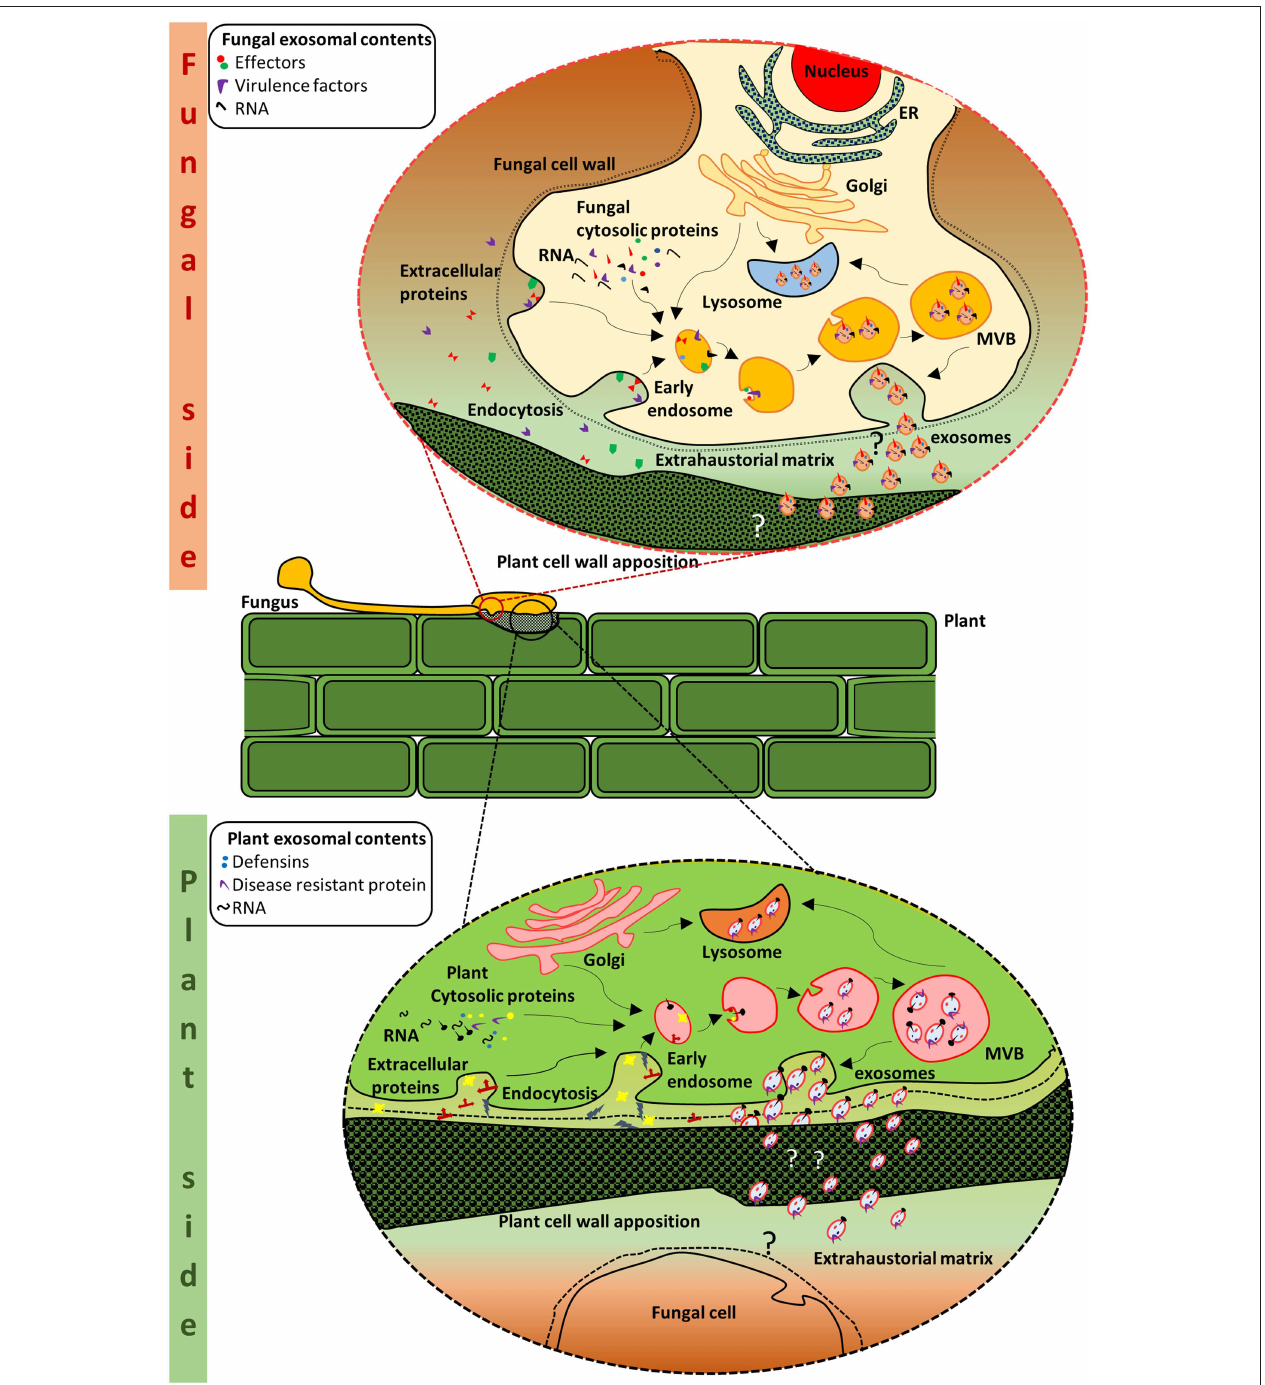
FIGURE 1 | Schematic representation of putative crosstalk via EVs at the plant-fungal interface. Exosome biogenesis and secretion in the fungal side: MVBs are formed from the early endosomes. Within the MVBs, invagination of the limiting membrane results in the formation of intraluminal vesicles which are packaged with protein and RNA cargo from the cell. The MVBs either fuse with the plasma membrane or with the lysosome for degradation. When the MVBs fuse with the plasma membrane, the intraluminal vesicles are released as exosomes. The exosomes are considered to contain various molecules including effectors that are required for the establishment of the pathogen and/or infection. Exosome biogenesis and secretion in the plant side: Similarly, on the plant side, vesicles from the MVBs may contain innate immunity proteins and defense molecules that can impede fungal growth or lead to alterations in the fungal cell wall. Thus, the plant and its fungal counterpart could utilize the exosomes as one of the many strategies in their mutual struggle for survival.